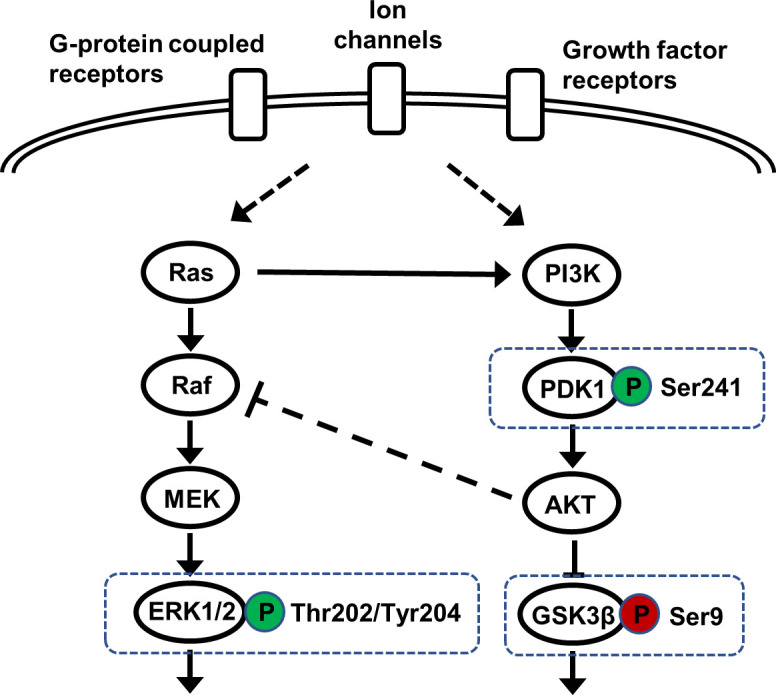
Schematic of AKT-dependent and interacting signaling pathways.Candidate pathways (boxed) upstream (PDK1), downstream (GSK3β), and parallel (ERK) to AKT were examined by western blot analysis to assess the impact of Akt isoform deficiency on signaling in the brain.